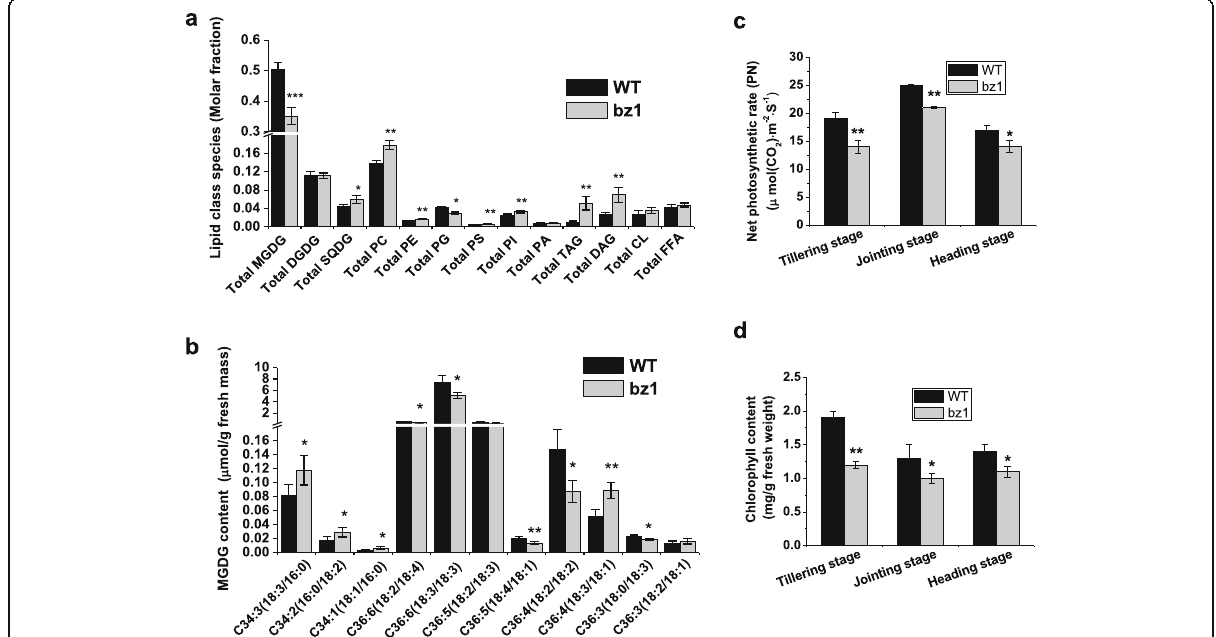
Fig. 5 The BZ1 mutation influences biosynthesis of galactolipids and impairs photosynthesis efficiency and chlorophyll content. a Total lipid composition in leaves of wild-type (WT) and bz1 plants grown in paddy fields. SQDG, sulphoquinovosyl diglyceride; PC, phosphatidylcholine; PE, phosphatidylethanolamine; PG, phosphatidylglycerol; PS, phosphatidylserines; PI, phosphatidylinositol; PA, phosphatidic acids; TAG, triacylglycerols; DAG, diacylglycerols; CL, cardiolipins; FFA, free fatty acids. b Fatty acid composition of MGDG from WT and bz1 plant leaves. The results are means ± SE of five independent assays. c-d Detection of net photosynthetic rate ( P N ) (c) and chlorophyll content ( d ) of WT and bz1 at three developmental stages, more than 20 representative leaves were selected for measuring. *, ** and *** indicates significant differences between WT and bz1 by t -test at P < 0.05, 0.01 and 0.001,